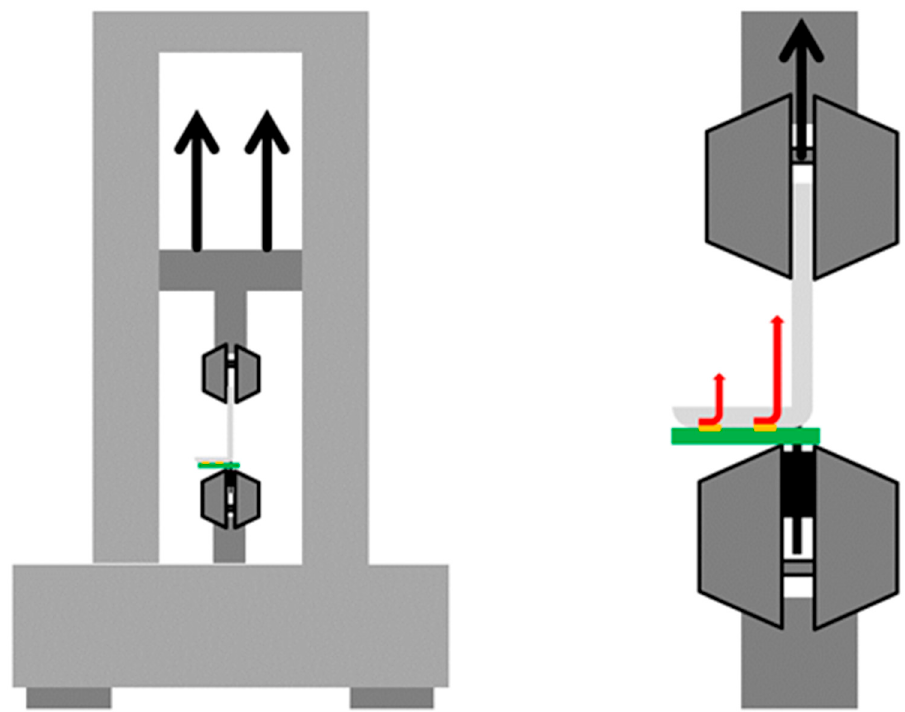
Figure 5. Peeling test setup, in which the samples were clamped to the blank and pulled on the